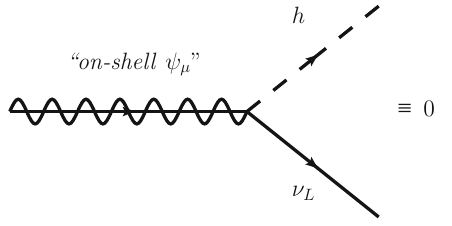
Fig. 1 ψ μ – h – ν L coupling with vertex factor ic 3 / 2 γ μ . Scatterings in which ψ μ is on shell must all be forbidden since c 3 / 2 γ μ ψ μ vanishes on mass shell by the constraint (4). This ensures stability of ψ μ against decays and all sort of co-annihilations